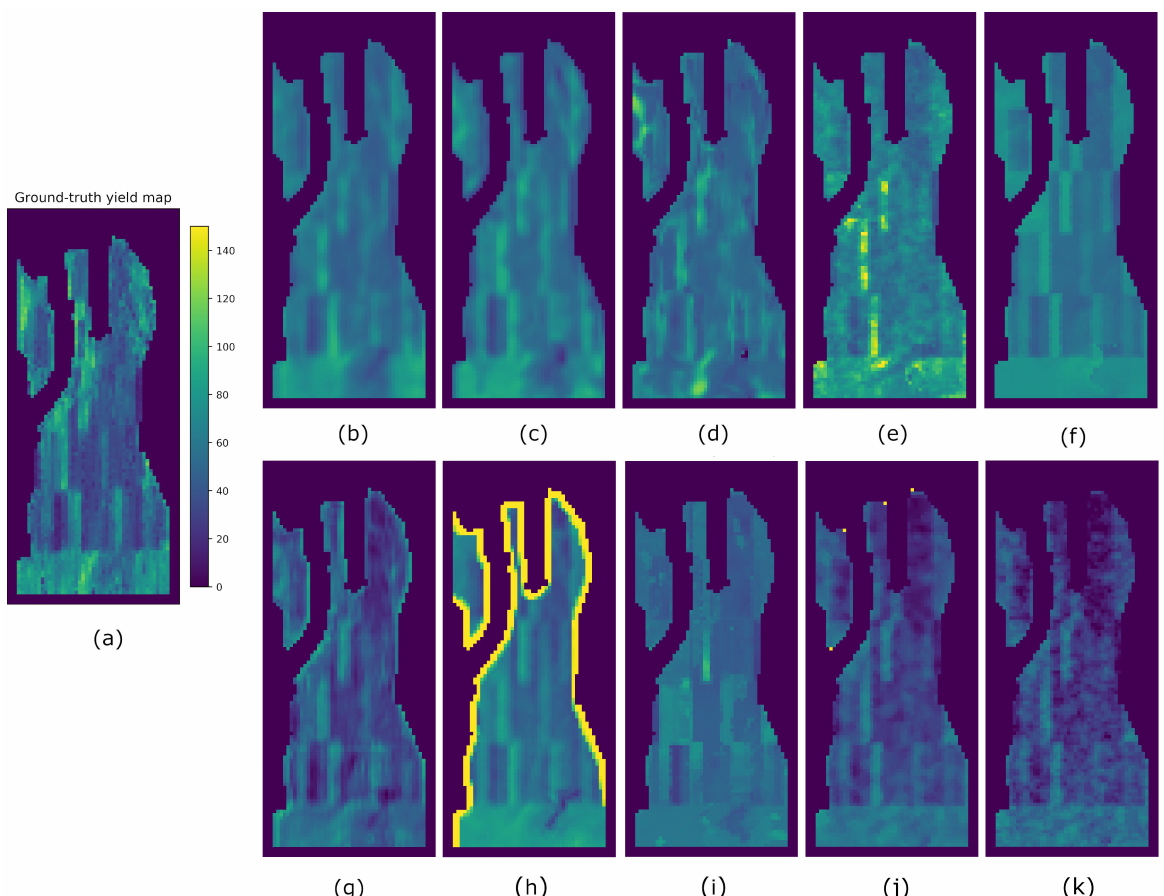
Figure 10. Yield prediction comparison on the G3 field using split A. ( a ) Ground-truth. ( b ) Hy- per3DNetReg ( N = 5). ( c ) Hyper3DNetReg ( N = 3). ( d ) Hyper3DNetReg ( N = 1). ( e ) Ad- aBoost.App. ( f ) SAE. ( g ) 3D-CNN. ( h ) CNN-LF. ( i ) RF. ( j ) BMLR. ( k ) MLR.